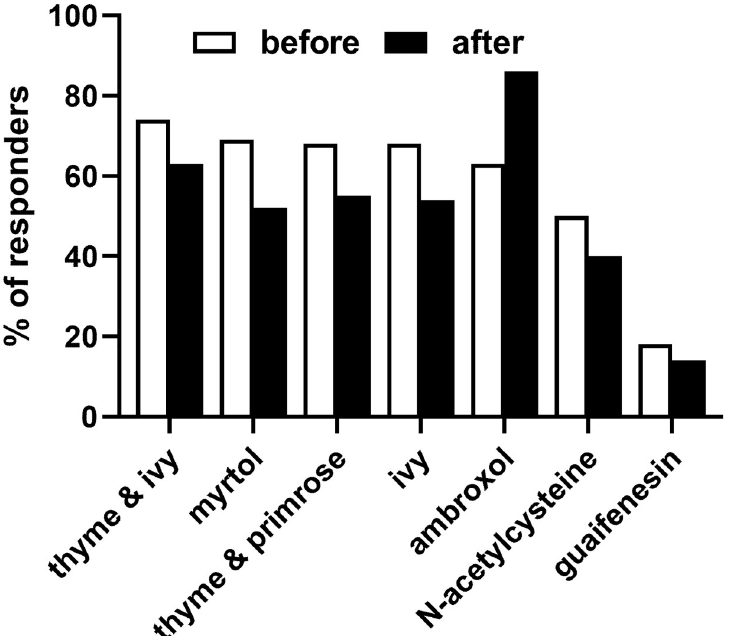
Fig 3. Perceived strength of evidence related to 7 selected anti-cough treatments as reported before and after being shown excerpts of an applicable guideline. Data are shown as % of responders rating strength of evidence as very good or